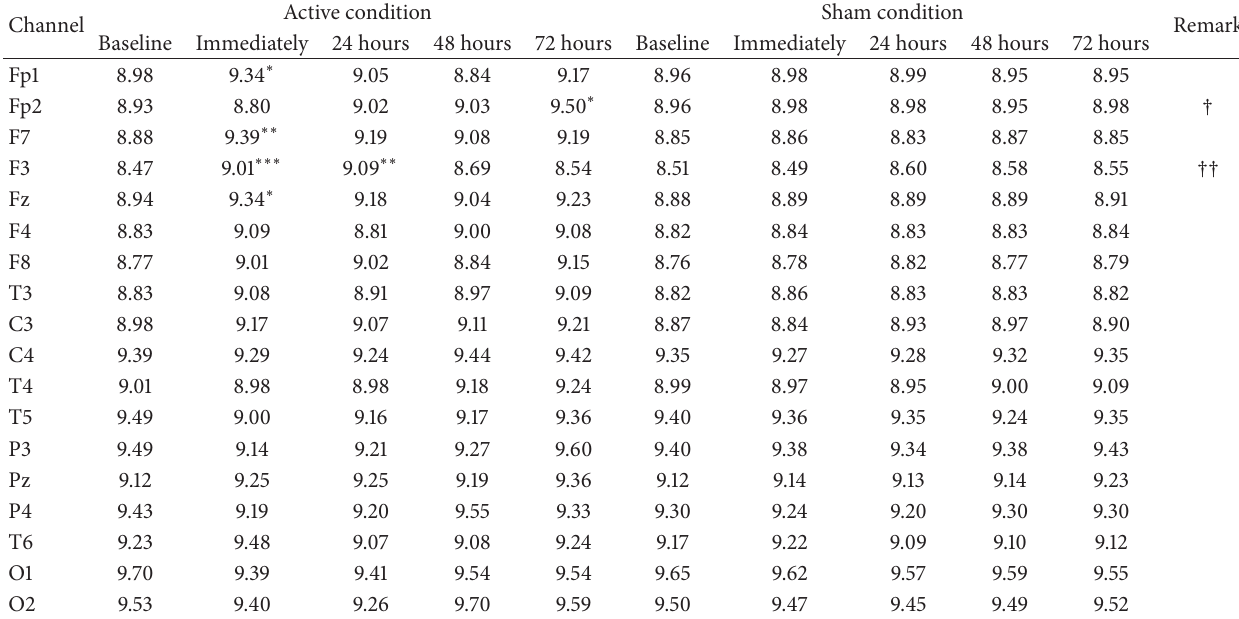
Table 2: Peak alpha frequency (PAF) scores of EEG recorded from different electrode